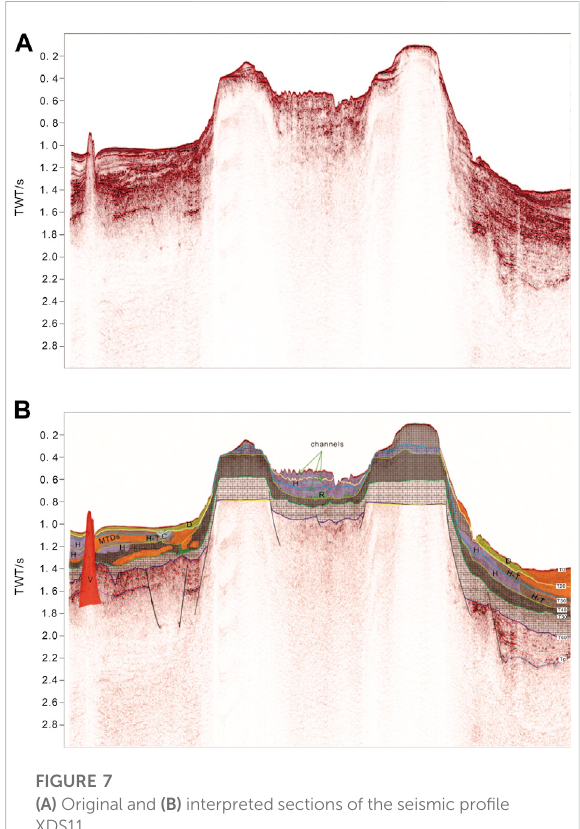
FIGURE 7 (A) Original and (B) interpreted sections of the seismic pro fi le